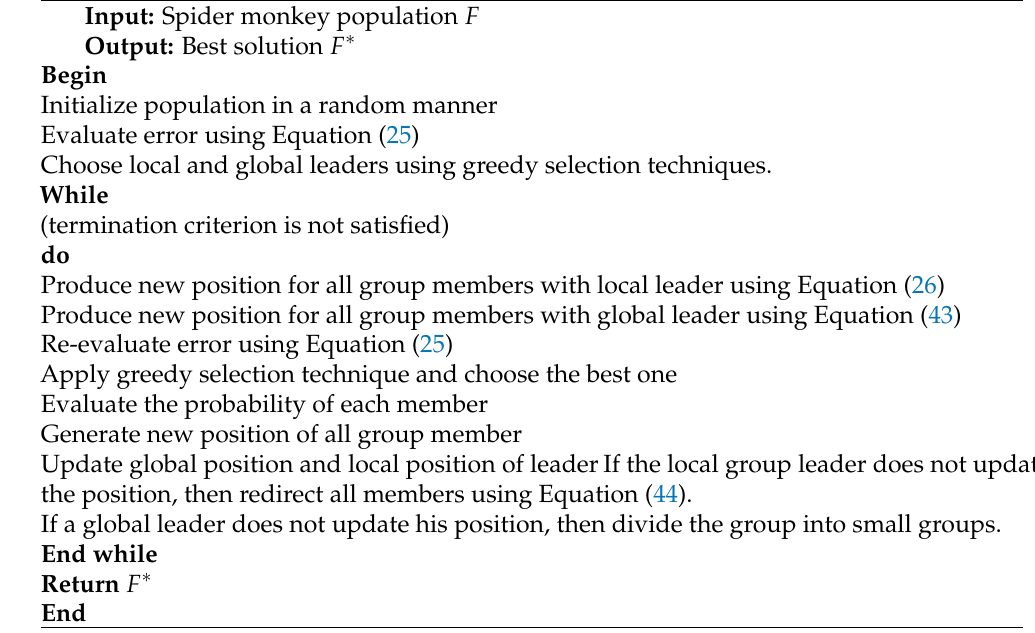
Algorithm 1 Pseudo code of proposed spider